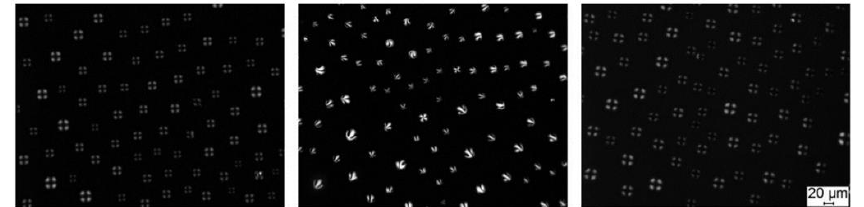
Figure 3. Polarized light microscopy images of surface-anchored LC droplet patterns in a different solution. Reprinted with permission from ref. [73]. Copyright 2014 John Wiley and Sons. The scale bar is 20 µm.